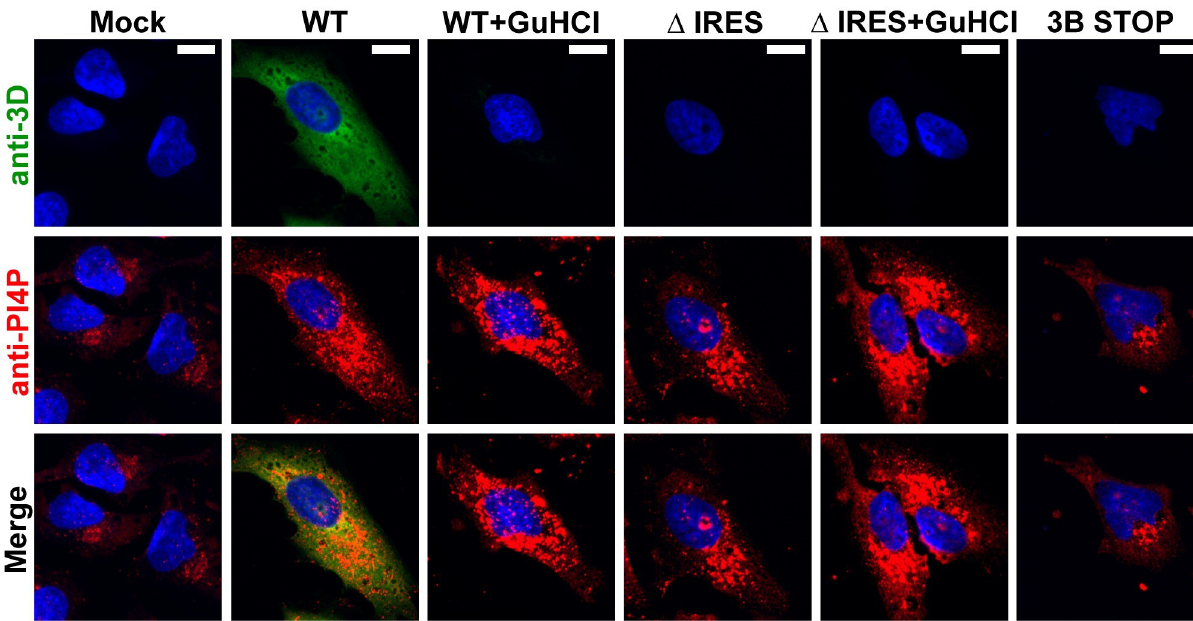
Fig 7. Induction and redistribution of PI4P serve an indirect method to detect production of 3CD by the IRES-independent translation mechanism. Immunofluorescence of cells after transfection. HeLa cells were transfected with in vitro transcribed subgenomic replicon RNAs: WT; Δ IRES, and a full-length genomic RNA with two STOP codons after the 3B-coding sequence: 3B STOP. WT and Δ IRES transfected cells were also treated with 3 mM GuHCl. Six hours posttransfection, cells were immunostained for the presence of PI4P (red) and 3D (green). Nucleus was stained with DAPI (blue). Mock represents cells that were taken through the transfection protocol in the absence of RNA. PI4P was induced and redistributed in cells transfected with WT and Δ IRES, both in the absence and presence of GuHCl, but not 3B STOP. 3D was detected in cells transfected with WT in the absence of GuHCl only. Scale bars are equivalent to 10 μ m. GuHCl, guanidine hydrochloride; IRES, internal ribosome entry site; PI4P, phosphatidylinositol-4-phosphate; WT,